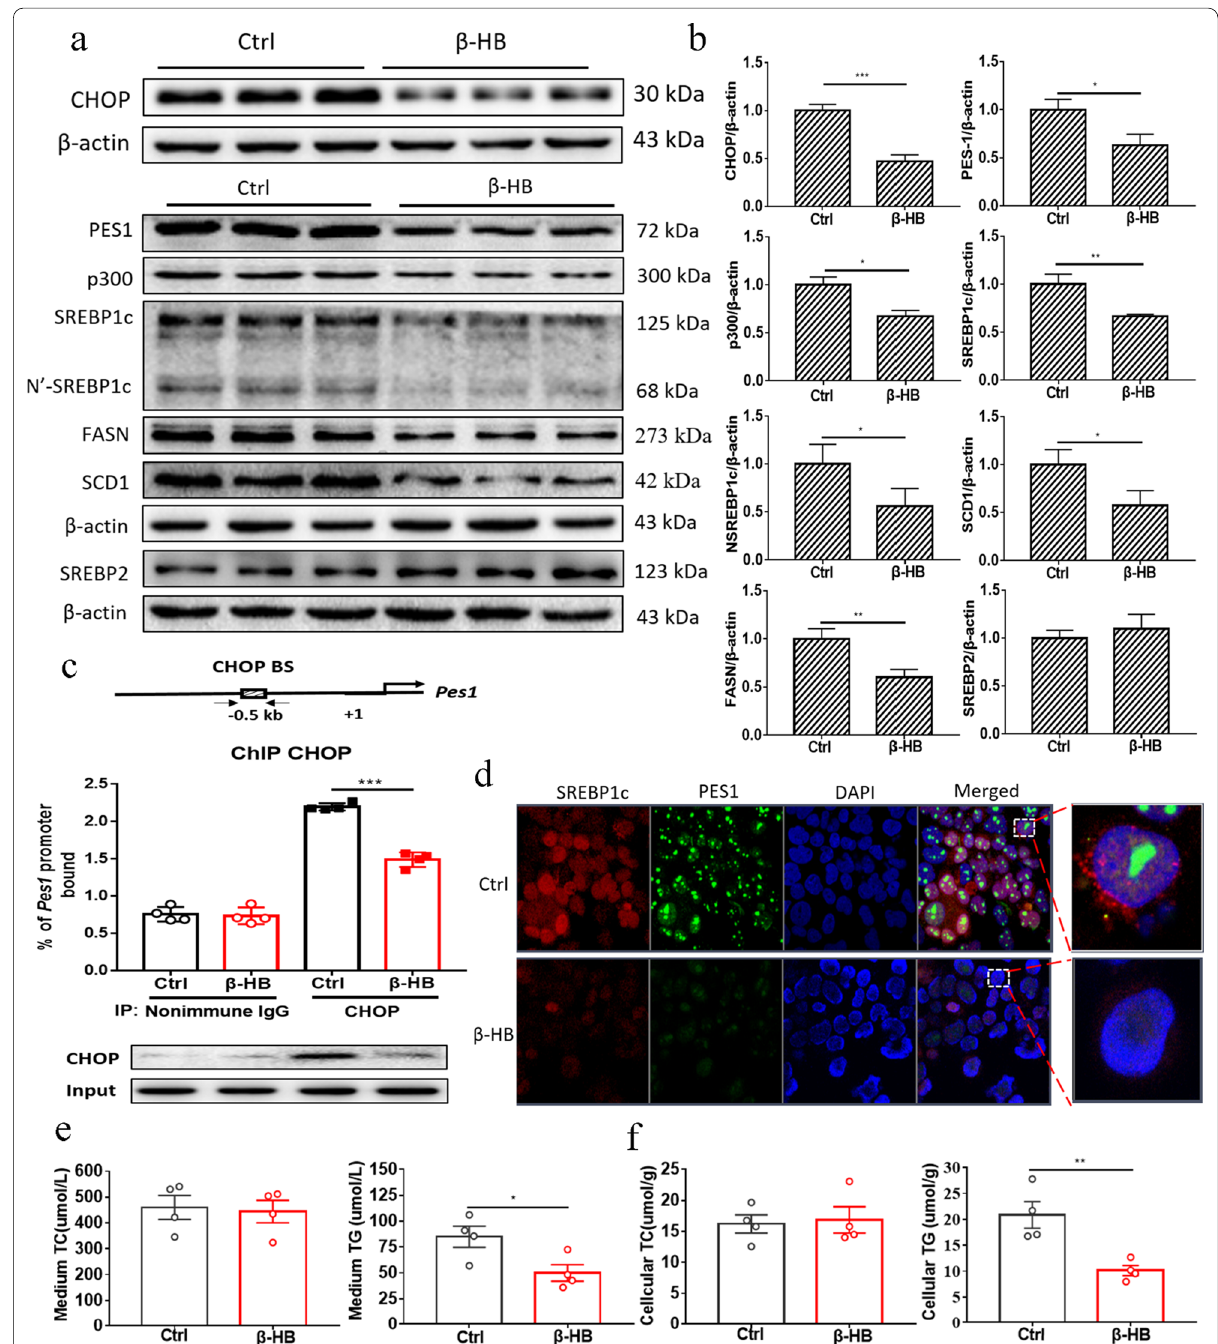
Fig. 3 β-HB decreased PES1 and triglycerides in cultured liver cells. a , b The protein levels of CHOP, PES1, p300, SREBP1c, SREBP2, FASN and SCD1 in hepatocytes were detected by immunoblotting after 1 mM β-HB treatment for 24 h. c β-HB decreased CHOP binding to Pes1 promoter. d Exhibited are immunofluorescence images of β-HB-treated liver cells for PES1 and SREBP1c expression and localization, Scale bar represents 20 um. The nuclei were stained with DAPI. e , f Demonstrated are the TG and TC levels respectively detected in the cultured media and liver cells after β-HB treatment. Ctrl (Control), β-HB (β-hydroxybutyric acid). Data were shown as mean SEM for each experiment performed independently 3 times. *P < 0.05, ± **P < 0.01, ***P < 0.001 compared with control (Student’s t